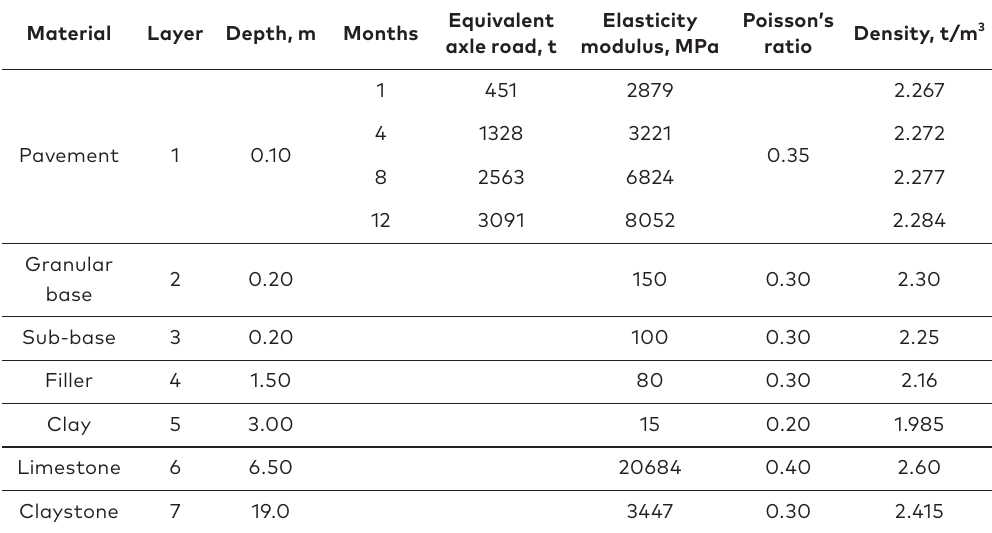
Table 9. Density, elasticity modulus, and Poisson’s Ratio parameters in N-type core